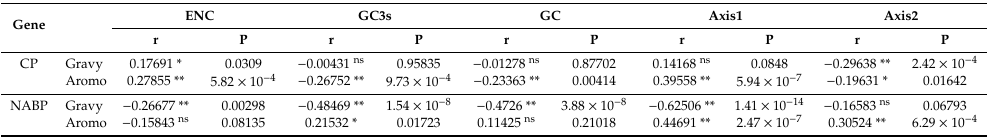
Table 2. Correlation analysis among GRAVY, ARO, ENC, GC3 S , GC, and the first two principle component axes.